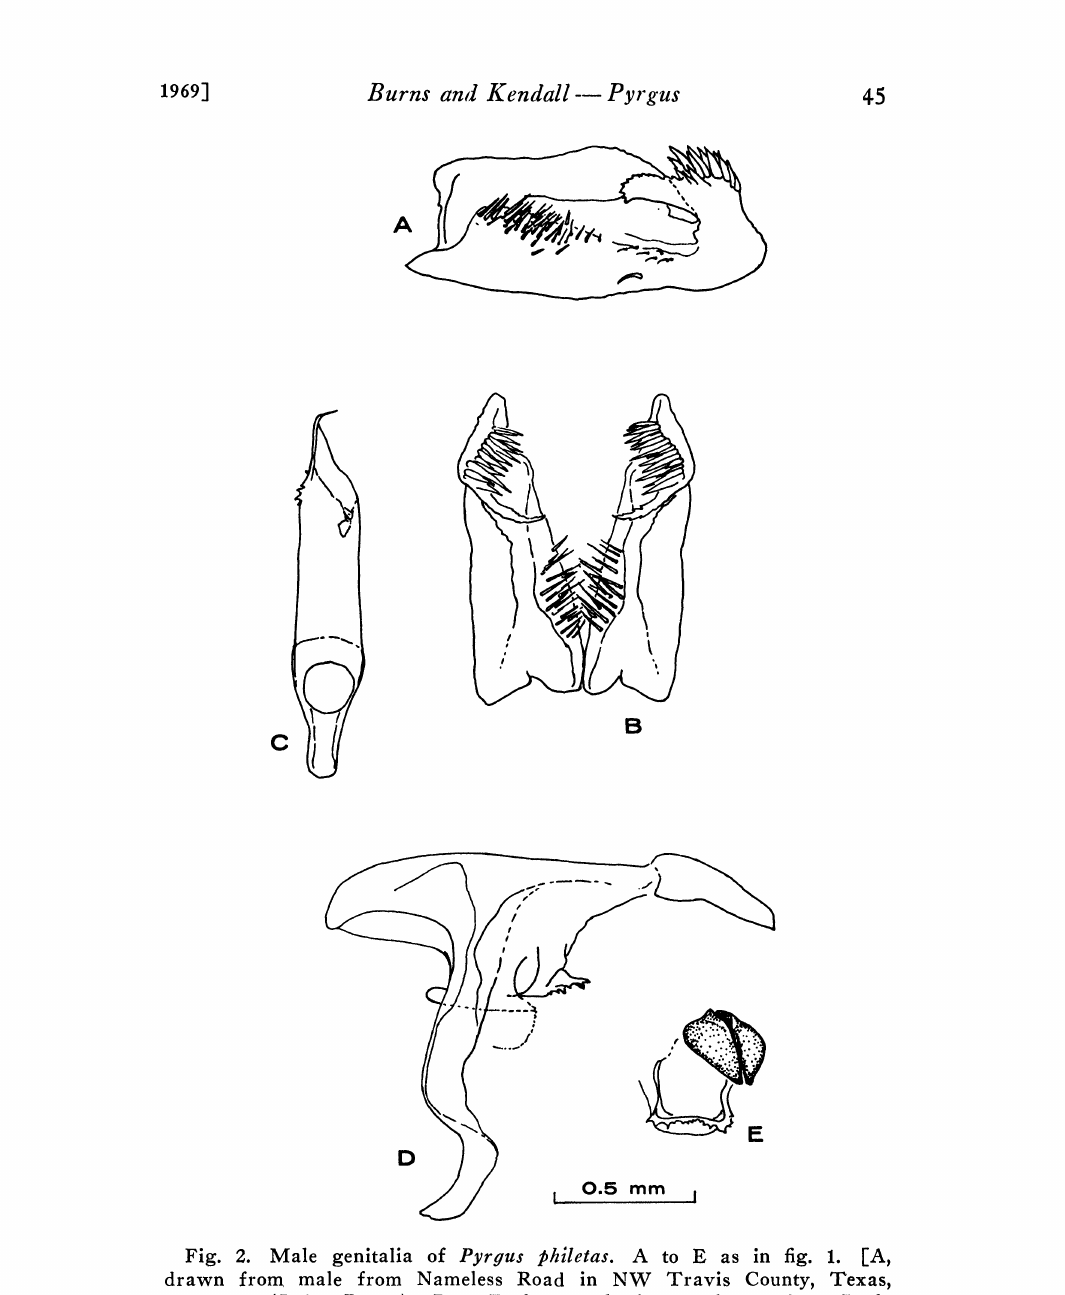
Fig. 2. Male genitalia of Pyrgus lhiletas. A to E as in fig. 1. [A, drawn from. male from Nameless Road in NW Travis County, Texas, VI-3-1967 (J. M. Burns); B to E, from male from Palmetto State Park, Gonzales County, Texas, IV-6-1967 (J. M.